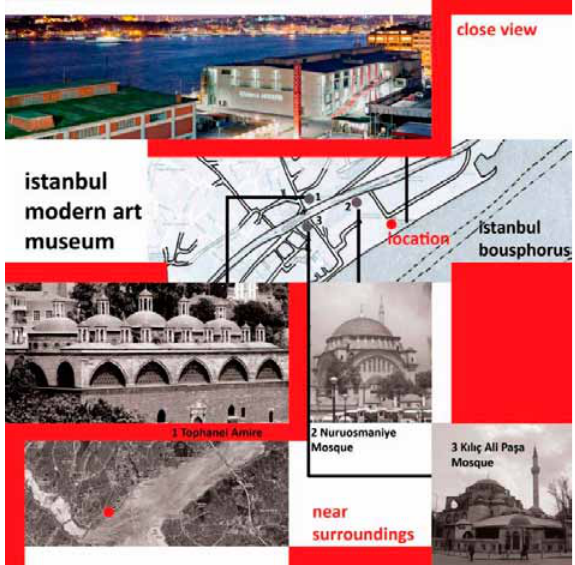
fig. 13. Istanbul Museum of Modern art, YaP installation (www.istanbulmodern.org) fig. 14. Istanbul Museum of Modern art, collage by